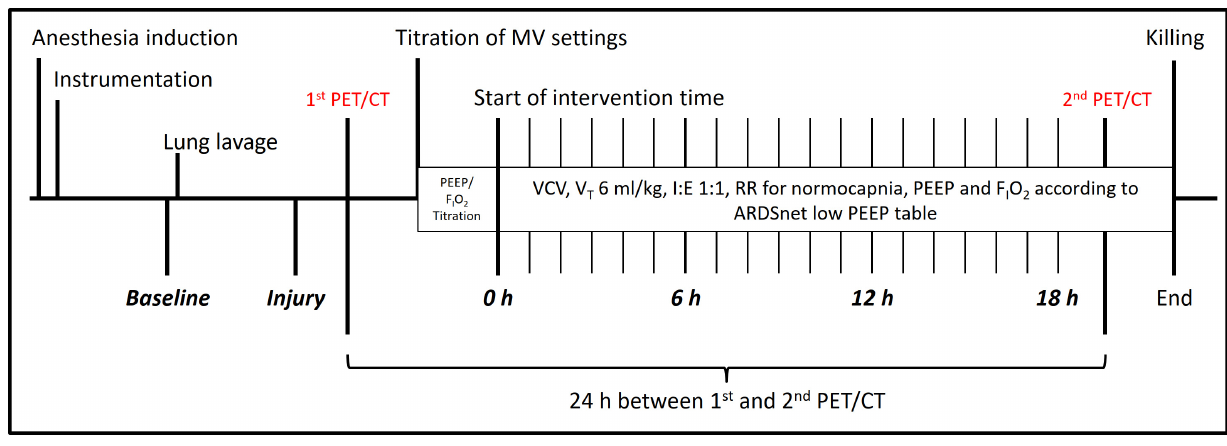
Frontiers in Physiology |